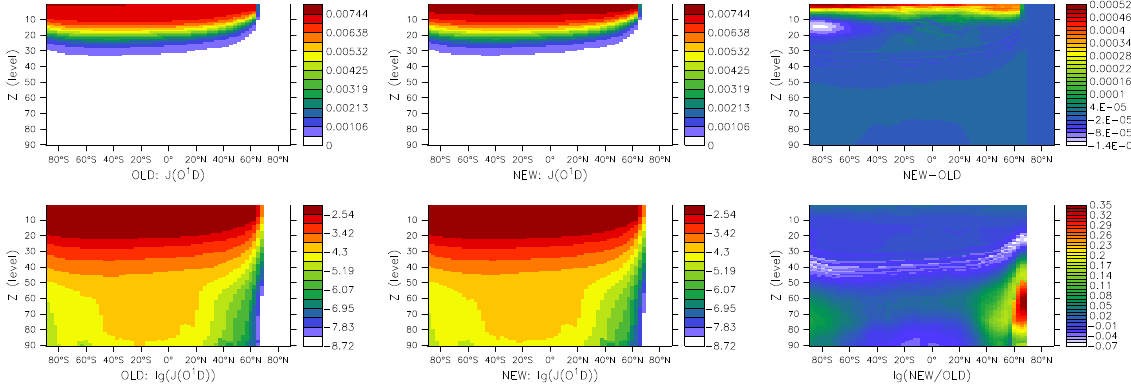
Figure 3. Comparison of the vertical profiles of the old and new J values (in s − 1 ) for O 3 → O ( 1 D ) , calculated for 1 January 2000, 02:00UTC at a longitude of 138 ◦ E and 90 model levels (up to 0.01hPa). The first row is plotted on a linear scale, the second on a logarithmic scale. The left column shows the old result, the centre column the new result, and the right column the differences.